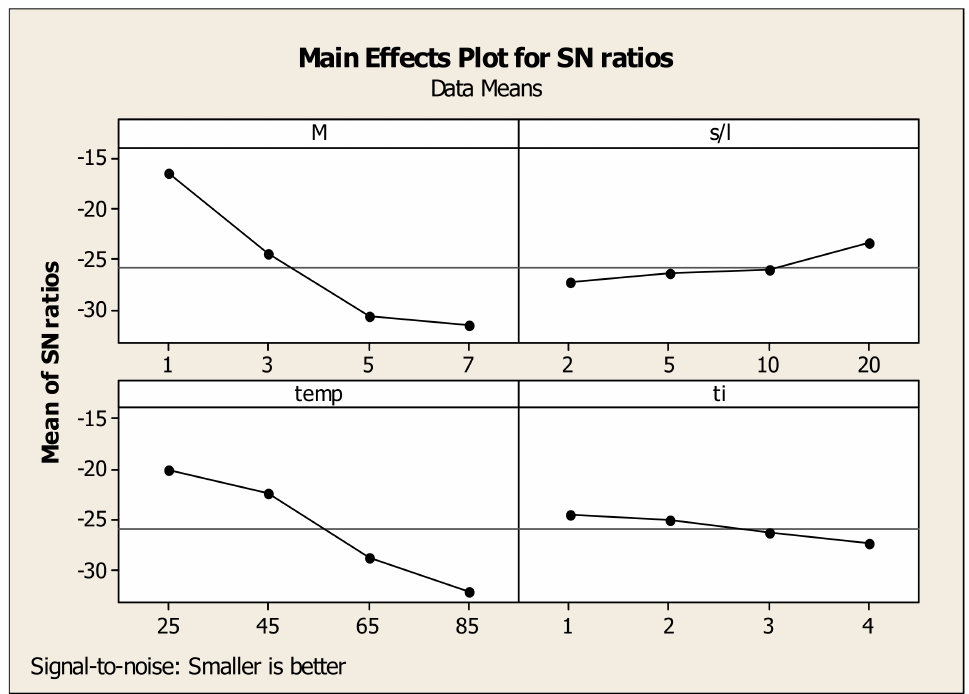
Figure 11. Effects of each factor associated with their levels on the statistical performance of S/N ratio for Fe